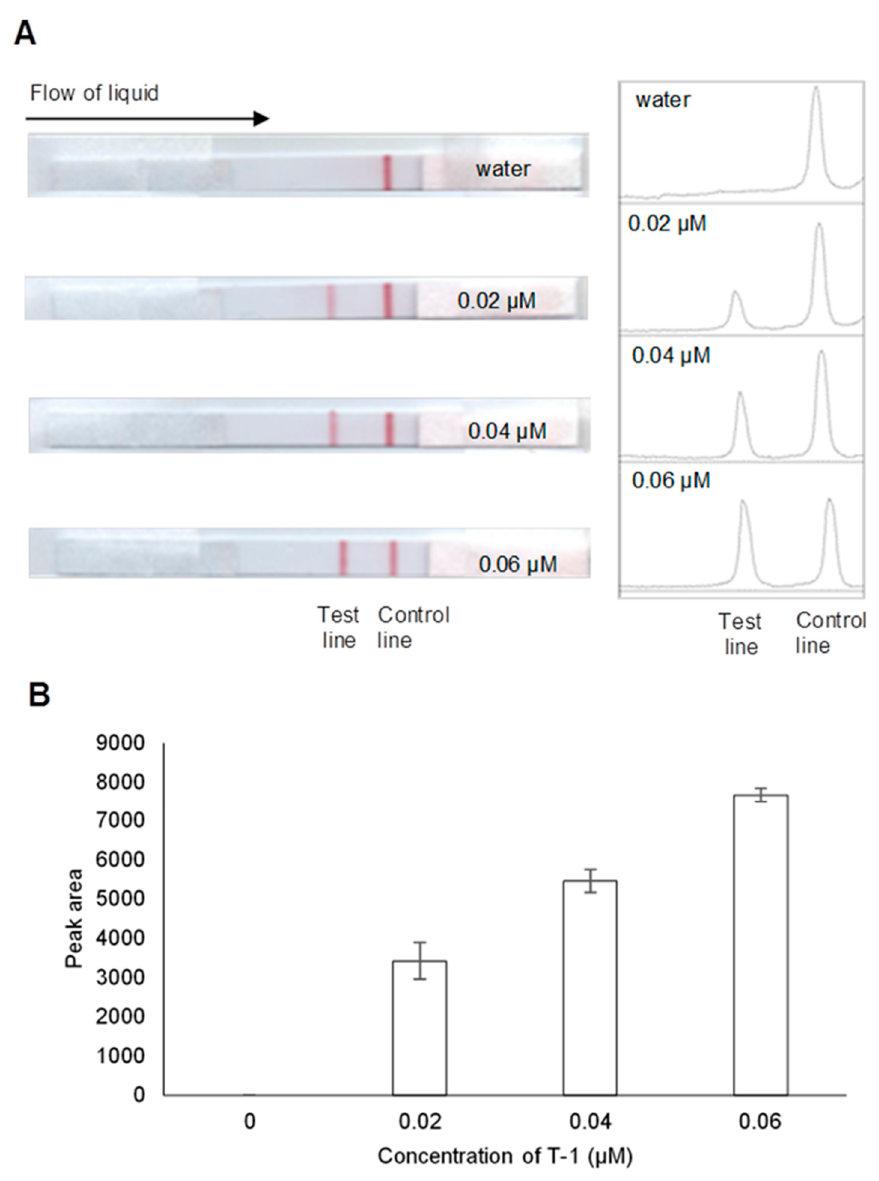
Figure 1. ( A ) Photo images of valid lateral flow biosensor (LFB) results at indicated concentrations of T-1 and their corresponding profile plots generated from ImageJ analysis. ( B ) Histogram representing peak areas of the test lines responding to 0 (water), 0.02, 0.04, and 0.06 µM T-1. Error bars represent standard deviation ( n = 3).